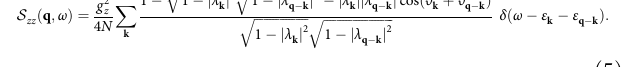
q ffiffiffiffiffiffiffiffiffiffiffiffiffiffiffiffiffiffiffiffiffiffi ffiffiffiffiffiffiffiffiffiffiffiffiffiffiffiffiffi q 1 (cid:3)j λ q (cid:3) k j 2 1 (cid:3)j λ k j 2